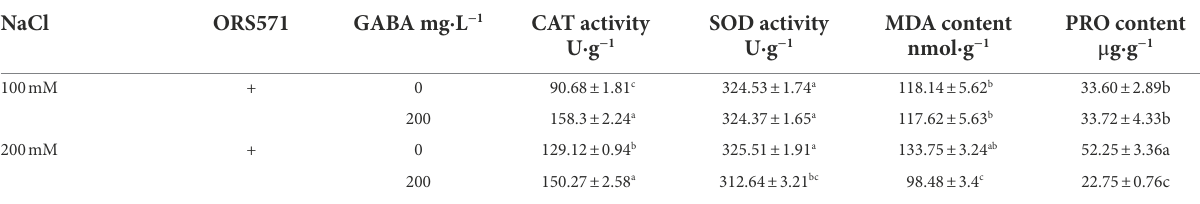
Different lower-case letters in each column shape indicate a significant difference at p < 0.05 by statistical